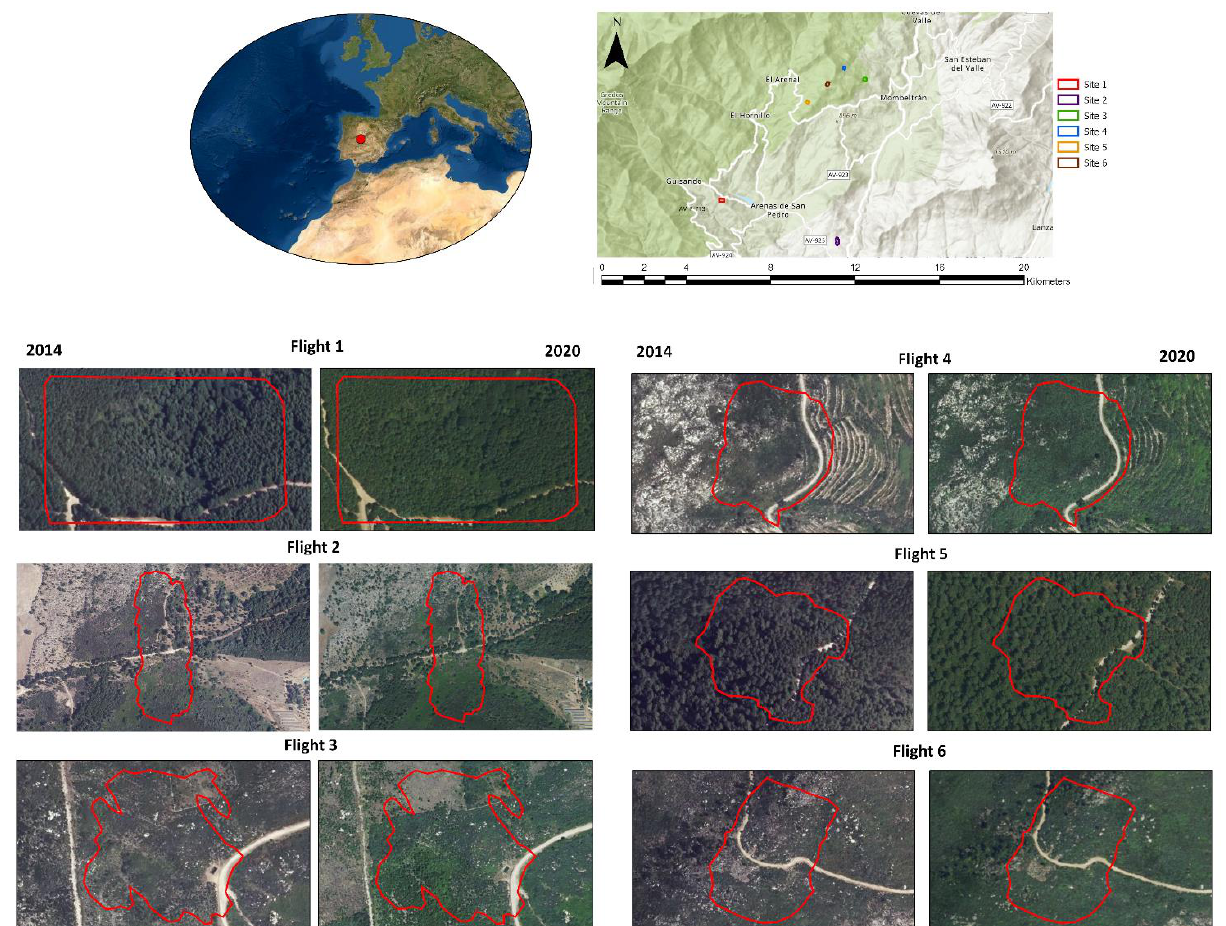
Figure 1. Location of the sites where different flights were carried out. In the left panels the ortho- photos are shown of the year corresponding to the first flight (2014) which was carried out at na- tional level with low-density LiDAR data (0.5 points/m 2 ); and in the right panels, the orthophotos (2020) closer to the second flights (2019) done with high-density LiDAR data (300 points/m 2